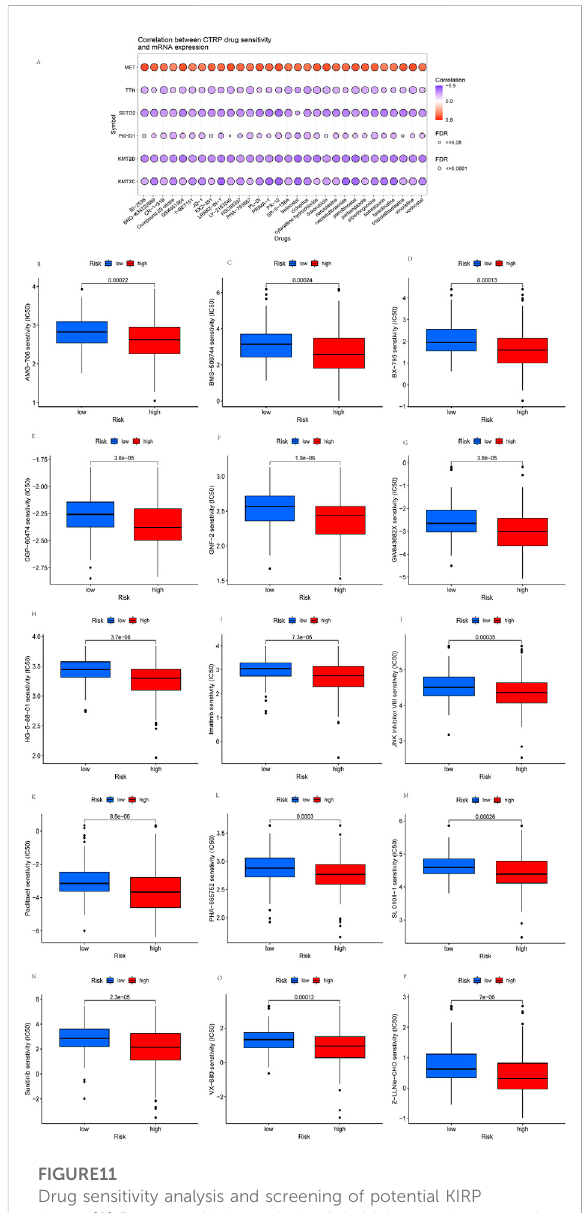
FIGURE11 Drug sensitivity analysis and screening of potential KIRP drugs. (A) Drug-sensitivity analysis of six high-mutation genes in KIRP. (B – P) Potential 15 drugs for